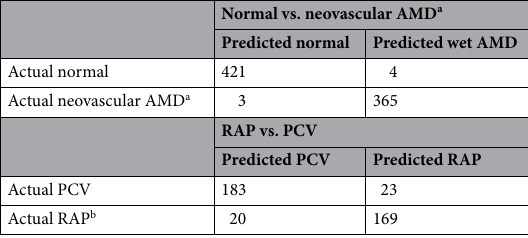
Table 2. Sensitivity, specificity, and accuracy of the model for detecting neovascular AMD and classifying RAP and PCV OCT images. Neovascular AMD, neovascular age-related macular degeneration; RAP, retinal angiomatous proliferation; PCV, polypoidal choroidal vasculopathy; OCT, optical coherence tomography. a The sensitivity of the classifier for detecting wet AMD eyes was 99.2%, the specificity was 99.1%, and the accuracy was 99.1%. b The sensitivity of the classifier for detecting RAP was 89.4%, the specificity was 88.8%, and the accuracy was